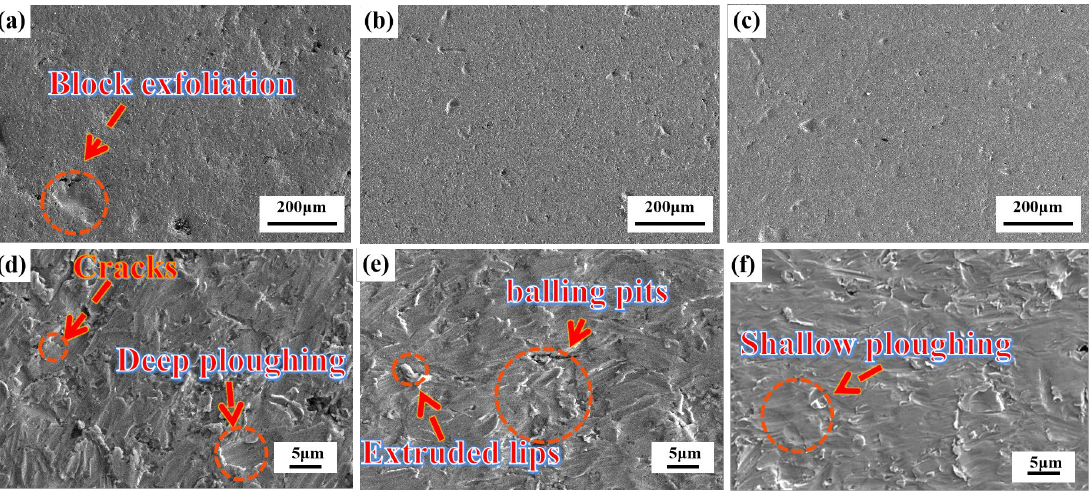
Figure 13. Micro-morphologies of the coatings after erosion at 60°: ( a , d ) Fe-based coating, ( b , e ) 6% γ -Fe coating, and ( c , f ) 9% γ -Fe coating.